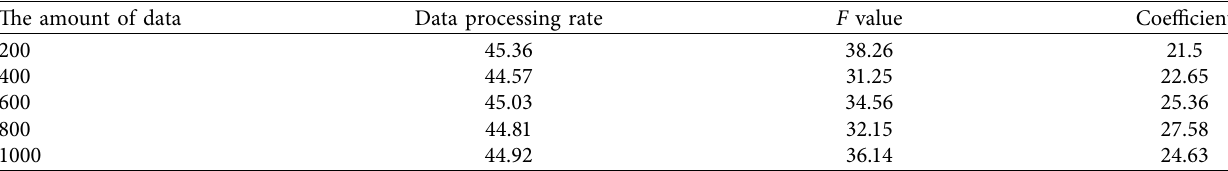
Table 2: Data processing rate.